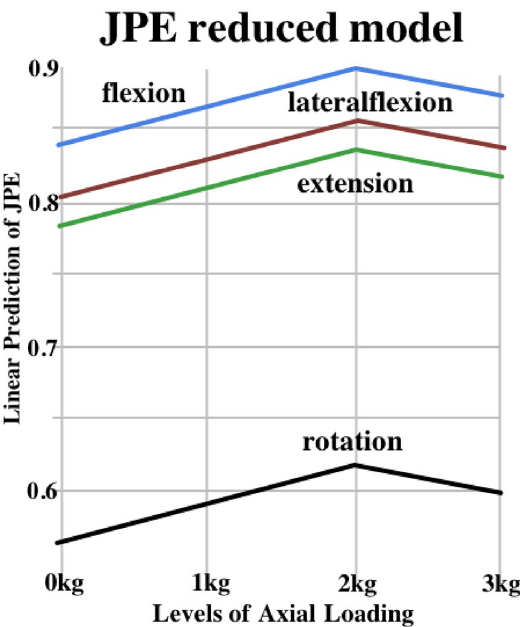
Figure 2. Linear prediction of the JPE reduced additive model without